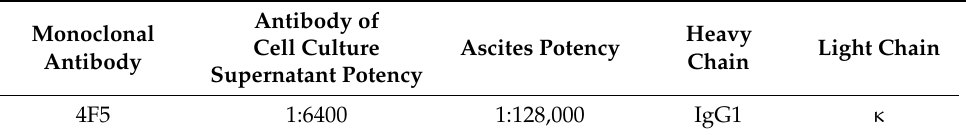
Table 2. Monoclonal antibody isotype identification and antibody